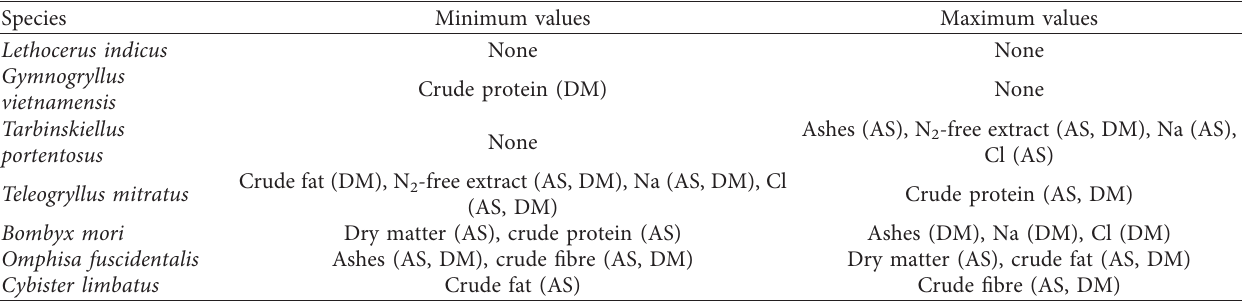
Table 3: Extreme values in relation to the insect